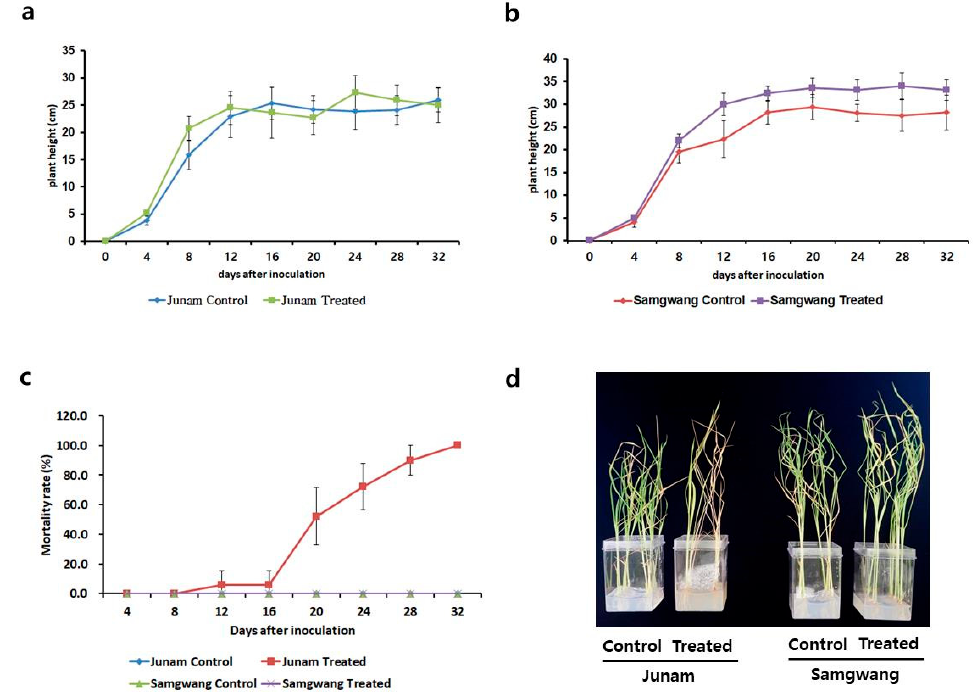
Figure 1. Phenotypic response of the parental varieties to Bakanae disease (BD). ( a ) Changes in plant height of treated and control ‘Junam’ seedlings; ( b ) changes in plant height of treated and control ‘Samgwang’ seedlings; ( c ) changes in the mortality rates of treated and control ‘Junam’ and ‘Samgwang’ plants; ( d ) a photographic record of treated and control ‘Junam’ and ‘Samgwang’ plants at 24 days following inoculation (DAI), indicating noticeable differences in response to BD.